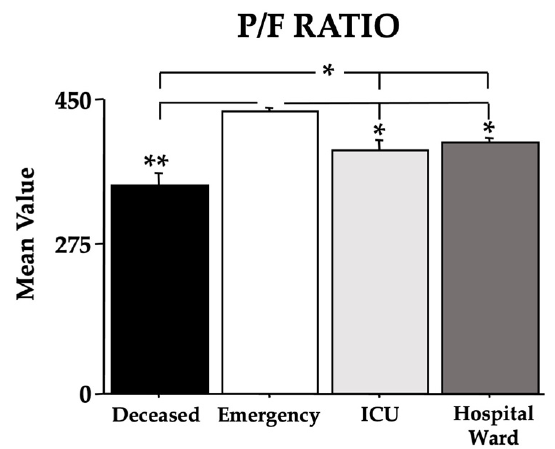
Figure 3. The Horowitz Index for Lung Function (P/F Ratio) of the recruited individuals. The error bars indicate pooled standard error means (SEM) derived from the appropriate error mean square in the ANOVA. The asterisks (* p < 0.05; ** p < 0.01) indicate post hoc differences between groups. The blood parameters determined by ANOVA are shown in Figures 4–7, while Table 4 shows the relative F and dF values (no sex effects were found and these data were not shown, except for ferritin). A main effect of morbidity was disclosed by ANOVA for CK, TnT, FBG, GGT, glycemia, CRP, aPTT, LDH, D-dimer, MGB, AST, and ferritin, with a significant potentiation in deceased individuals compared to the individuals in the emergency group (ps < 0.05 in post hoc analyses for the differences between